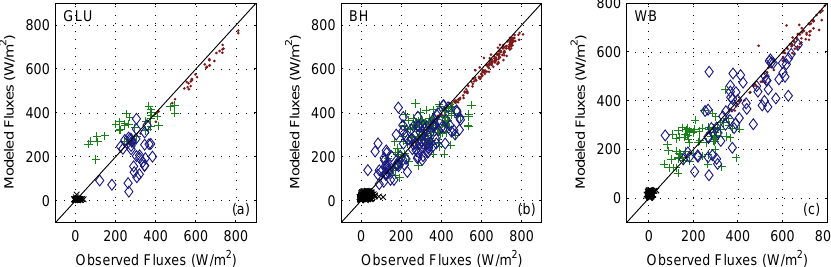
Fig. 7. Instantaneous modelled net radiation (points), latent heat (diamonds), sensible heat (crosses) and ground heat (x-es) fluxes at forested sites: coniferous (GLU, a ), coniferous (BH, b ) and deciduous (WB, c ). DTD was run using predominantly MODIS inputs, with f g estimated using VI and night-time fluxes ignored.